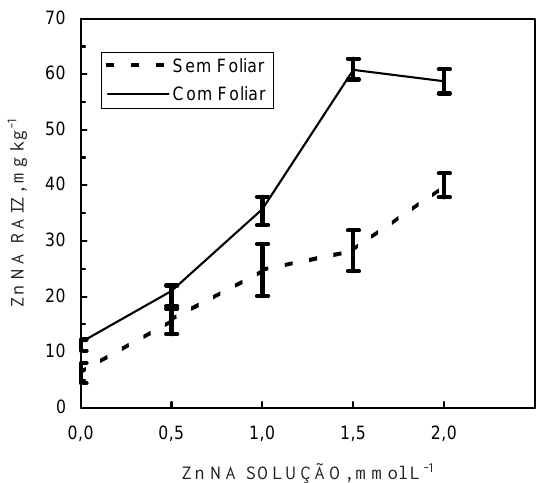
Figura 1. Teores de zinco nas raízes de milho, considerando a concentração do nutriente na solução nutritiva e a aplicação de zinco via foliar. As barras verticais mostram o desvio- padrão dos resultados.